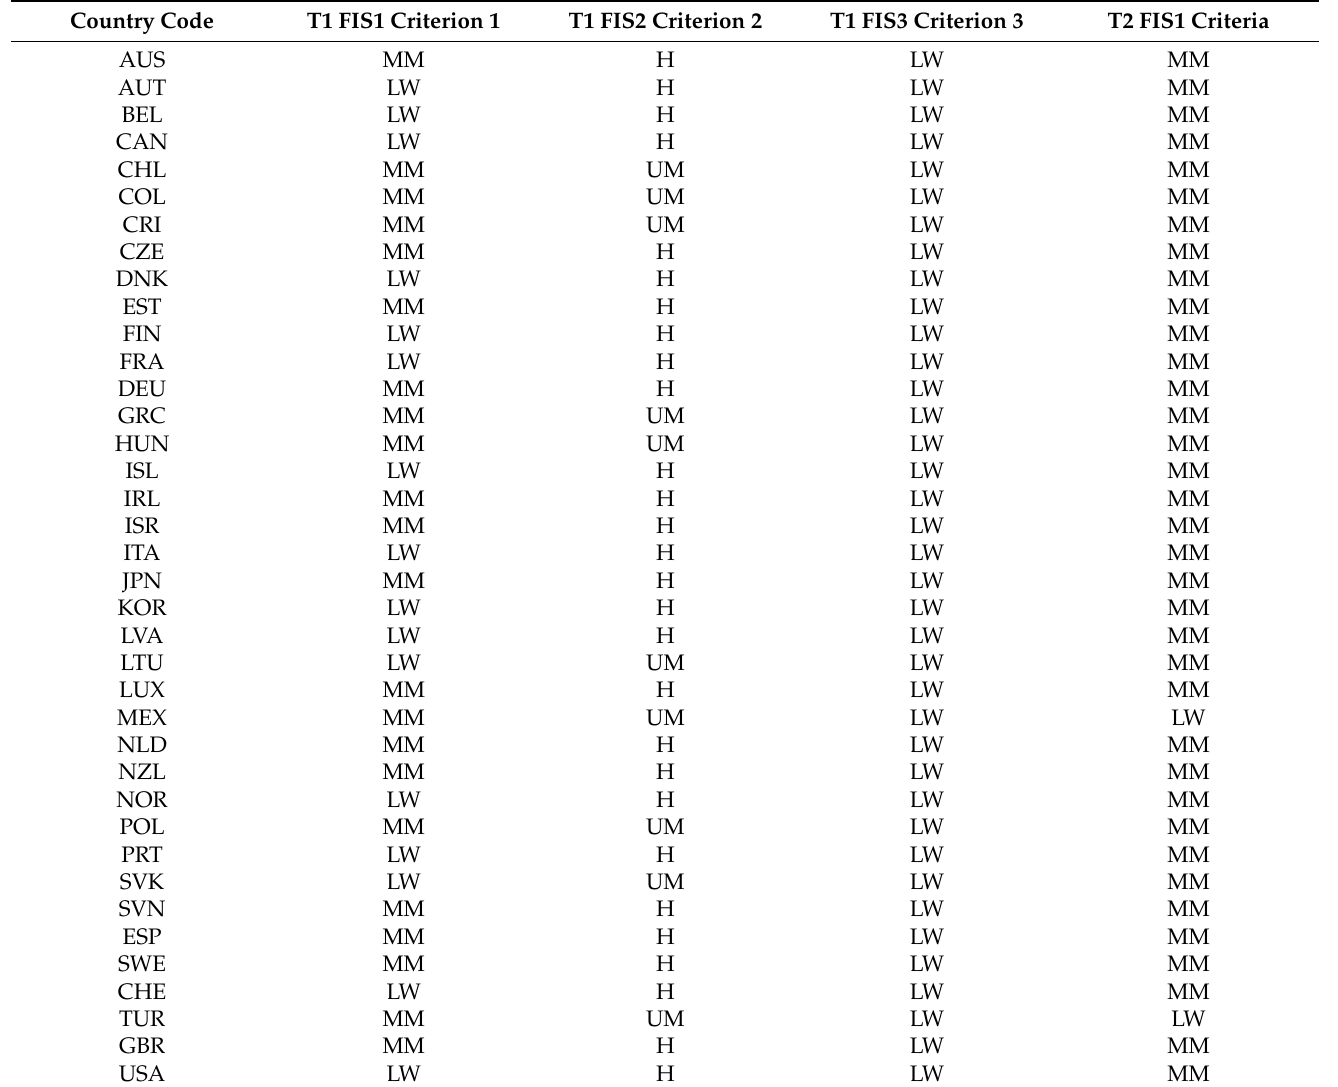
Table 18. Comparison of Type-1 (T1) and Type-2 (T2) fuzzy systems results